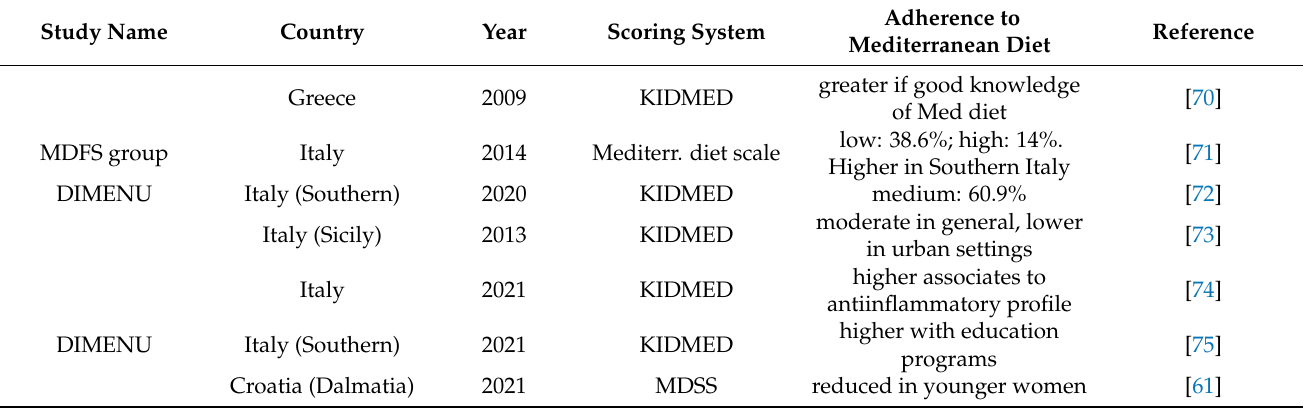
Table 3. Adherence to the Mediterranean diet and geographic location in adolescents .